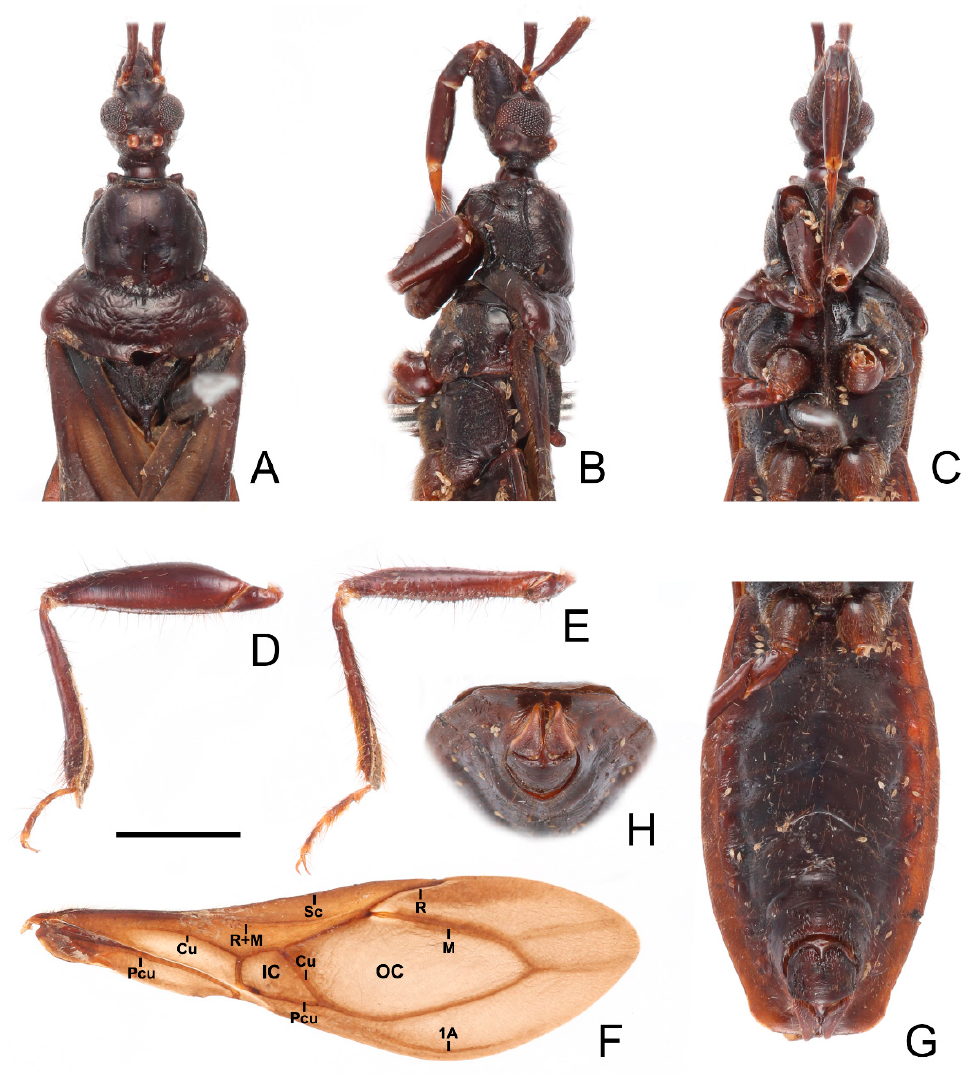
Figure 4. Sigicoris brumalis comb. nov. , male. ( A ) Anterior part of body with antennae and legs removed, dorsal view; ( B ) ditto, lateral view; ( C ) ditto, ventral view. ( D ) Left fore leg, ventral view. ( E ) Right mid leg, ventral view. ( F ) Right hemelytron, dorsal view. ( G ) Abdomen, ventral view; ( H ) ditto, caudal view. Scale bar = 2.00 mm. Abbreviations: 1A, first analis; Cu, cubitus; M, media; Pcu, postocubitus; R, radius; Sc, subcosta; IC, inner cell on membrane; OC, outer cell on membrane. Structure. Antennae, head, disc of scutellum, pleura, sterna, coxae, ventral surfaces and apex of femora, tibiae, lateral margin of corium, eighth abdominal sternite and genitalic part densely covered with golden, procumbent, short pubescence; first and second antennal segments, lateral margins of head and pronotum, femora and tibiae covered with brown, suberect to erect setae of varying lengths; apex of dorsal surfaces of tibiae and ventral surfaces of tarsi densely covered with yellow to yellowish brown, suberect setae; venter of abdomen sparsely covered with golden, long pubescence (Figures 2 and 3).